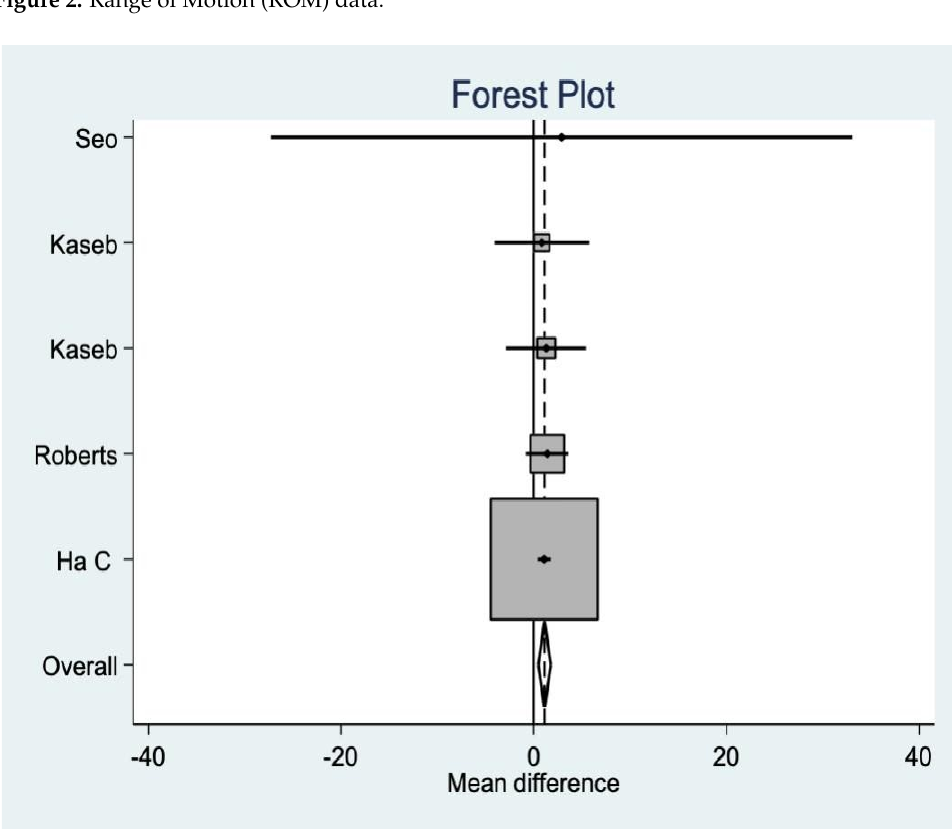
Figure 3. KSS clinical data.